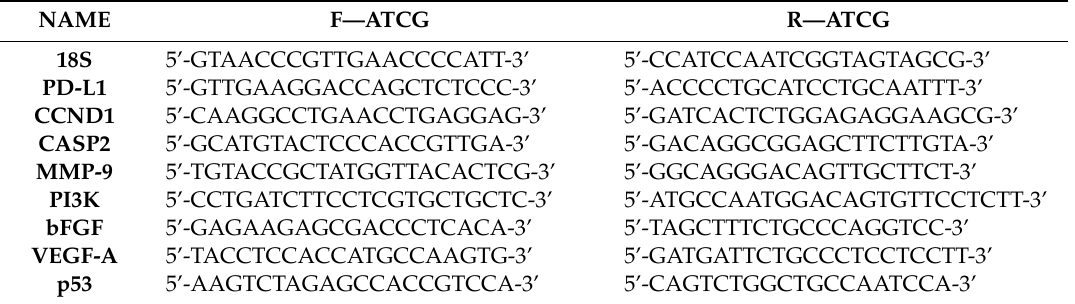
Table 1. Primer Sequences for Quantitative PCR on CRC Cell Lines and Primary Culture